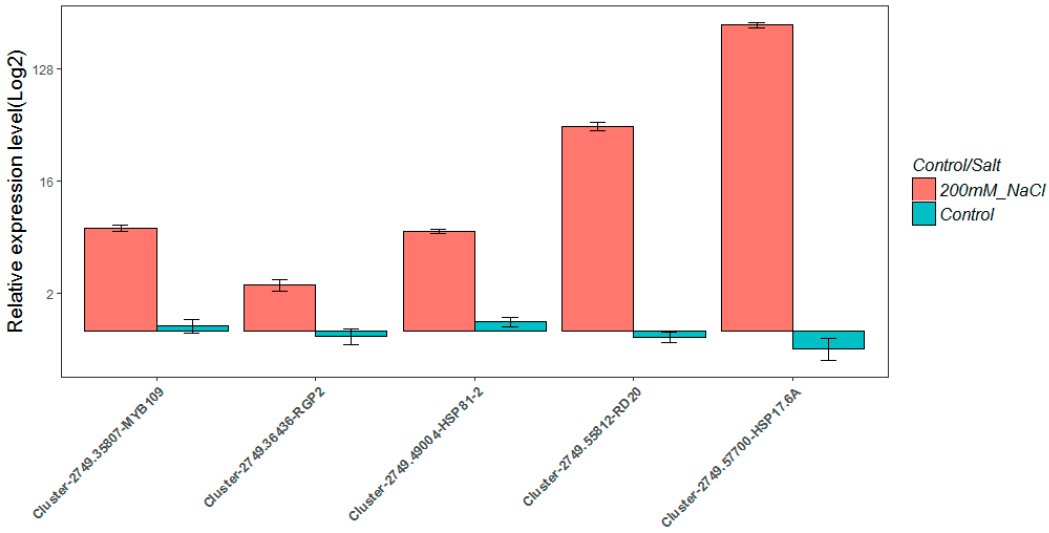
Figure 3. Real-time PCR verification of five up-regulated genes in C. reinhardtii . The red bars represent the qPCR results of samples under salt stress condition, while the corresponding blue bars represent the results of control samples. The individual black bars, representing the qPCR data, are the means ± SD of nine measurements (three technical replicates each for three biological samples).